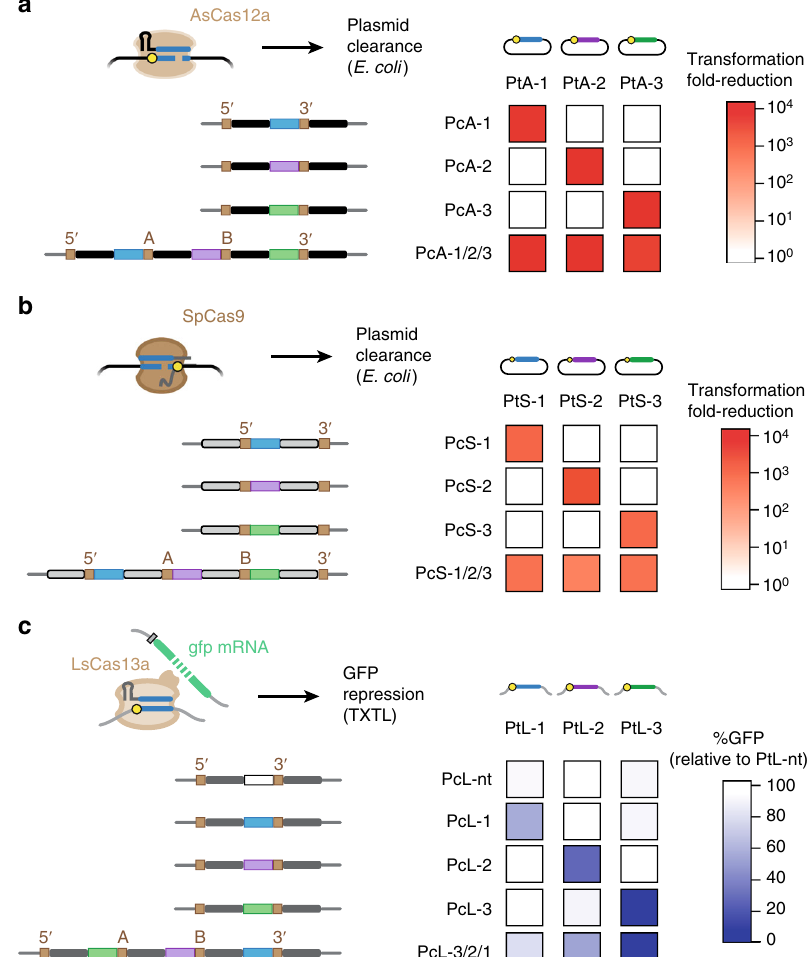
Fig. 3 CRATES can be used to generate CRISPR arrays that function with different Cas single-effector nucleases. a Multiplexed plasmid clearance by AsCas12a in E. coli . Spacers were designed to target a distinct protospacer fl anked by a PAM (yellow circle) in a transformed plasmid. The assembly junction is located at the 3 ′ end of the spacer to match the location of spacer trimming. E. coli cells harboring the AsCas12a plasmid and the target plasmid were transformed with a plasmid encoding the indicated CRISPR array or a no-spacer array, and the fold-change in the number of transformants was quanti fi ed. Values represent the average of three independent transformation experiments starting from separate colonies. b Multiplexed plasmid clearance by SpCas9 in E. coli . See a for details. The Cas9 plasmid also encodes the tracrRNA. The assembly junction is located at the 5 ′ end of the spacer to match the location of spacer trimming. Values represent the average of three independent transformation experiments starting from separate colonies. c Multiplexed RNA sensing by LsCas13a in a cell-free transcription – translation system. Reactions were conducted for 16 h following the addition of the LsCas13a plasmid, the indicated array plasmid, a plasmid expressing one of the targets, and the GFP plasmid. Target recognition leads to non-speci fi c degradation of the GFP mRNA by LsCas13a, thereby reducing GFP production. GFP levels from end-point fl uorescence measurements are reported relative to that for a non-targeted transcript (PtL-nt) and the same targeting array. Values represent the average of two TXTL experiments and are representative of at least three experiments conducted on different days. See Supplementary Fig. 5 for the assay and GFP time courses. All arrays were assembled using the junctions speci fi ed in Supplementary Table 4. Source data are provided as a Source Data fi